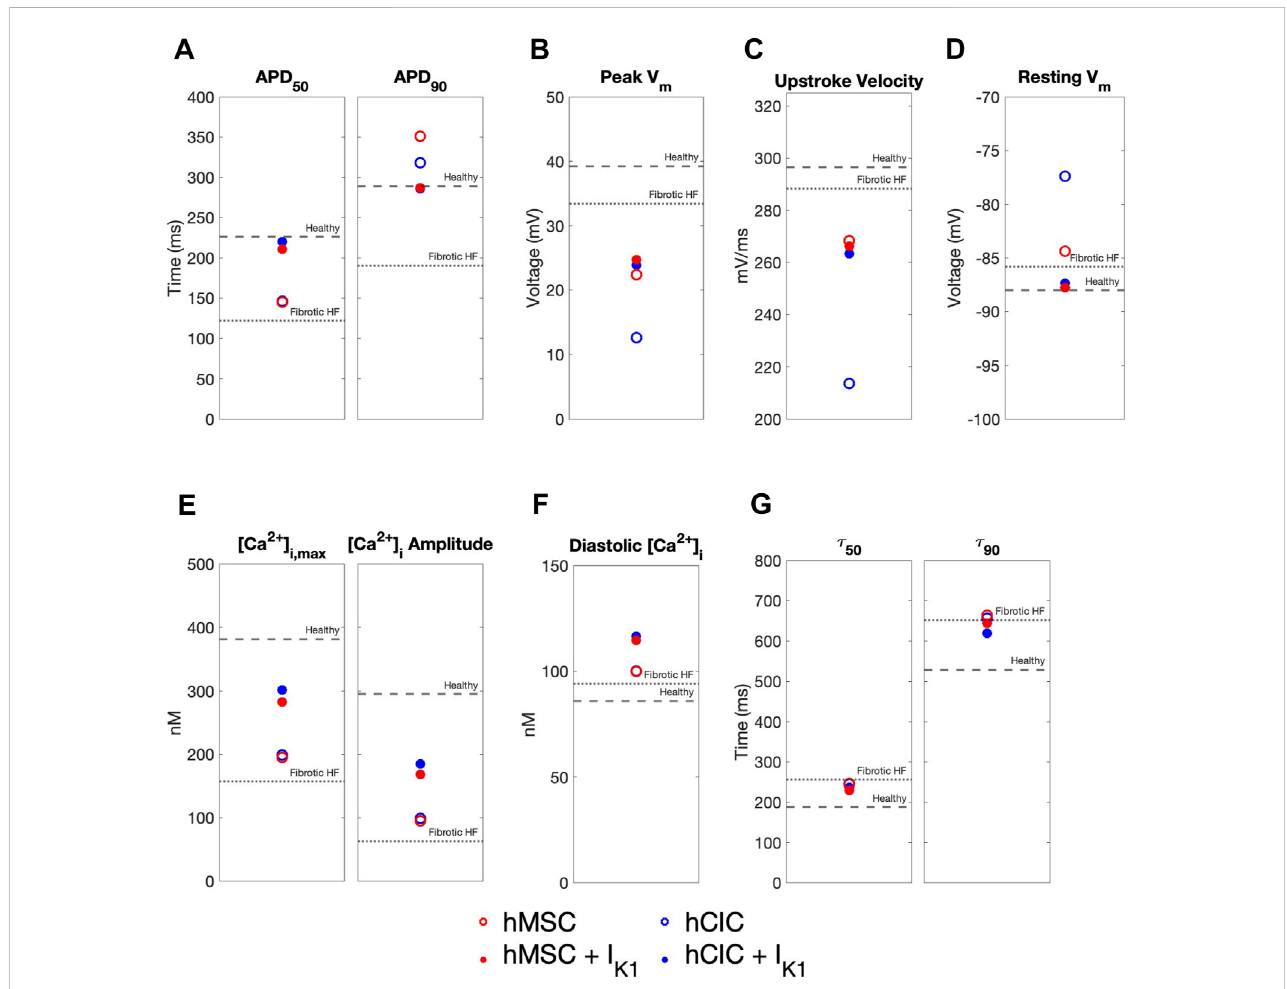
FIGURE 8 Effects of custom engineered human mesenchymal stem cell and c-kit + cardiac interstitial cell heterocellular coupling on fi brotic heart failure cardiomyocyte electrophysiology and calcium handling. Action potential and calcium transient metrics are shown for coupling fi brotic heart failure (HF) cardiomyocytes to human mesenchymal stem cells (hMSCs) and human c-kit + cardiac interstitial cells (hCICs) (red and blue circles, respectively) with and without cardiomyocyte inward recti fi er channel (I K1 ) expression ( fi lled and un fi lled, respectively) that achieved minimum total root mean square error of actionpotentialandcalciumtransientwaveforms(seepinkwaveformsinFigure7).Actionpotentialmetricsinclude: (A) Actionpotentialduration(APD)at50% repolarization (APD 50 ) and 90% repolarization (APD 90 ); (B) peak membrane voltage (V m ); (C) upstroke velocity; and (D) resting V m . Calcium transient metrics include: (E) peak intracellular calcium and calcium transient amplitude; (F) diastolic calcium; and (G) calcium relaxation time constant at 50% decay ( τ 50 ) and 90% decay ( τ 90 ). Values for healthy and untreated fi brotic HF cardiomyocytes are shown as dashed and dotted lines,